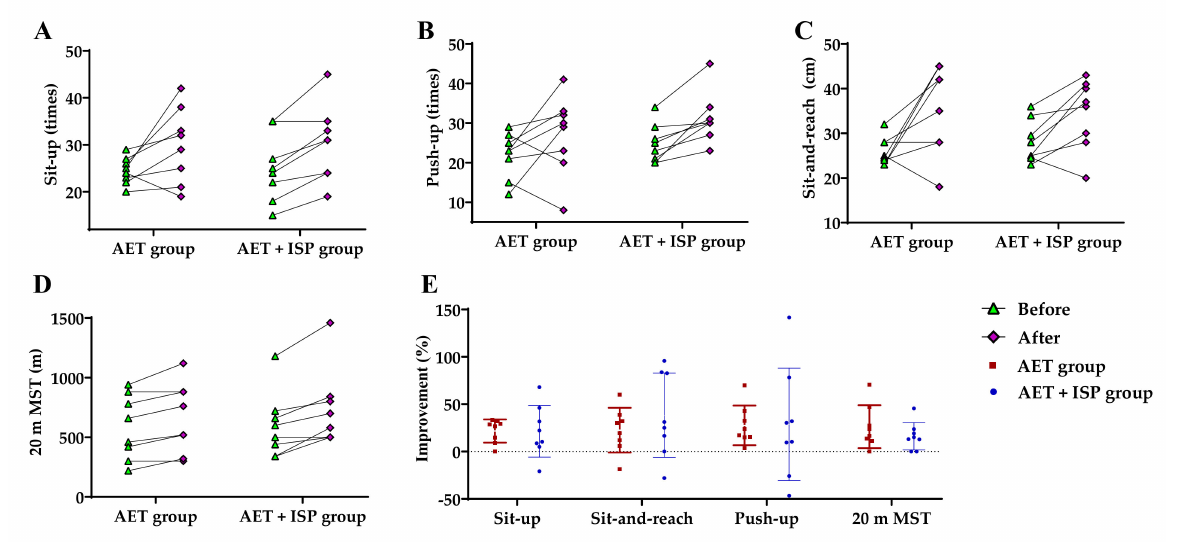
Figure 3. ( A – D ) The changes in physical fitness for the AET and AET + ISP groups before and after 8 weeks of intervention using various tests, as indicated; ( E ) the percent improvements of the two groups in the physical fitness means the percent gains in value for each